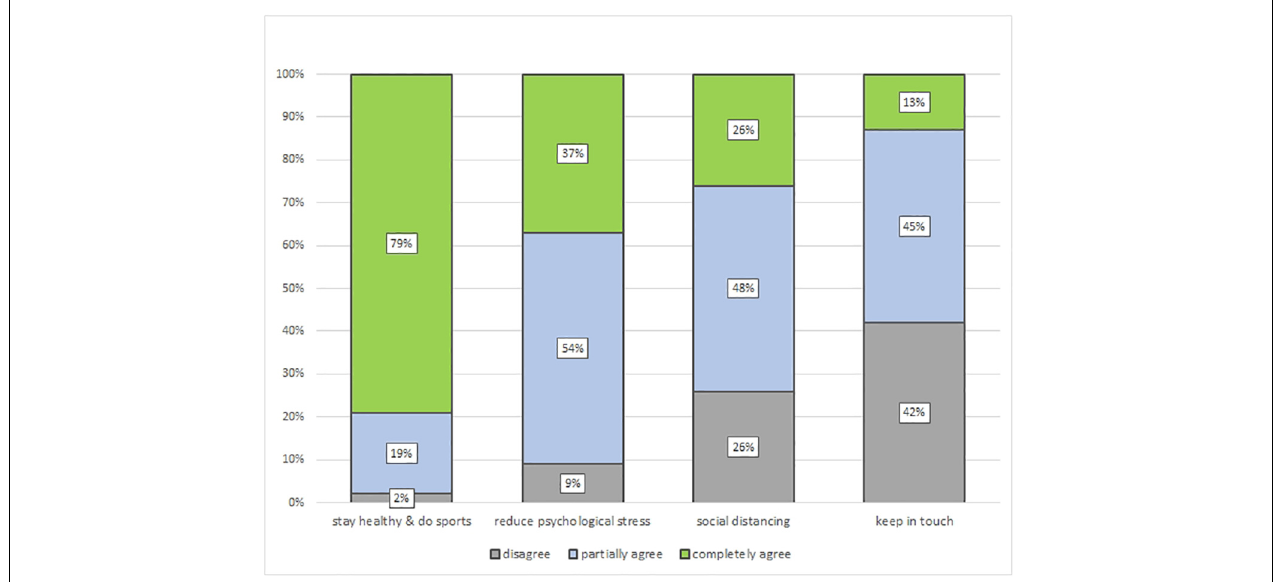
FIGURE 2 | Proportions of the four